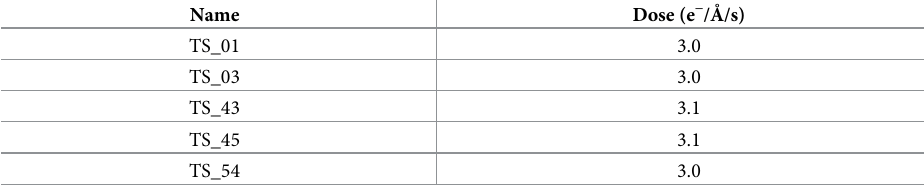
Table 1. Dataset. Tomogram name and dose rate of the 5 tomograms from the EMPIAR-10164 dataset that are used in the processing.